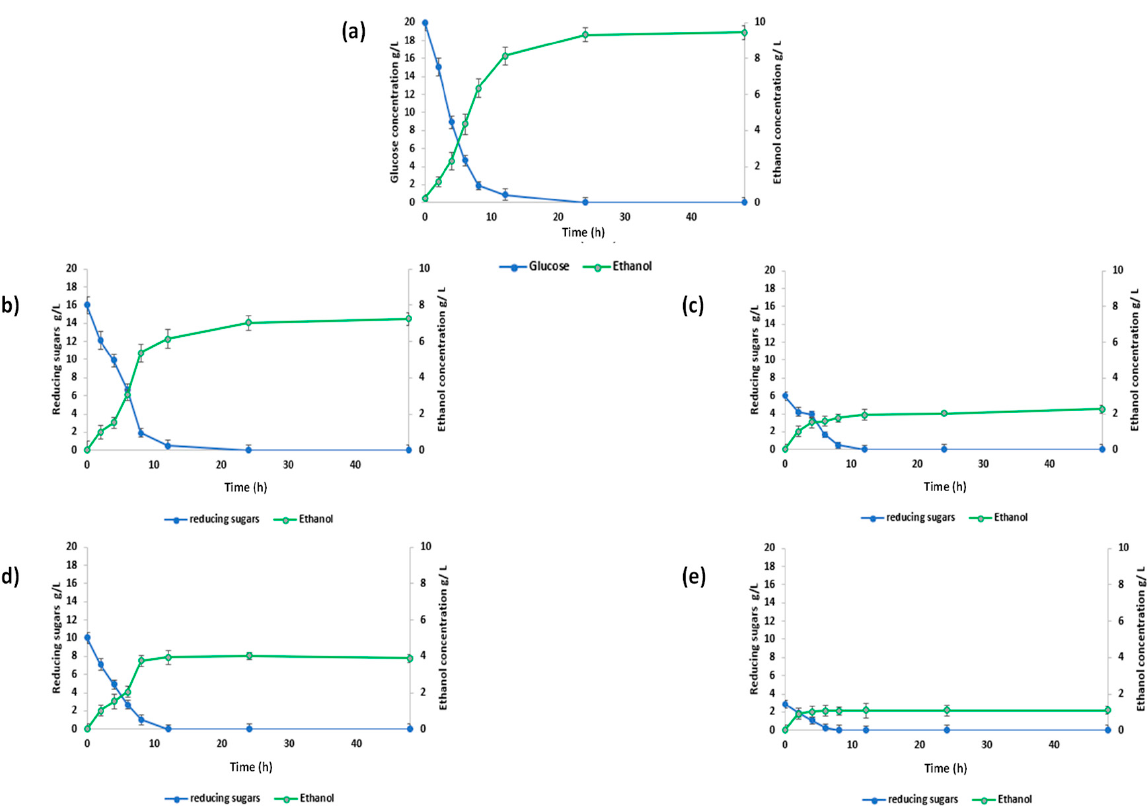
Figure 4. Reducing sugar and ethanol content (g/L) during 48 h of fermentation for the five samples studied: ( a ) glucose (control), ( b ) pretreated argan shell + Viscozyme L (30FBGU/g), ( c ) pretreated argan shell, ( d ) untreated argan shell + Viscozyme L (30 FBGU/g), and ( e ) untreated argan shell (control).